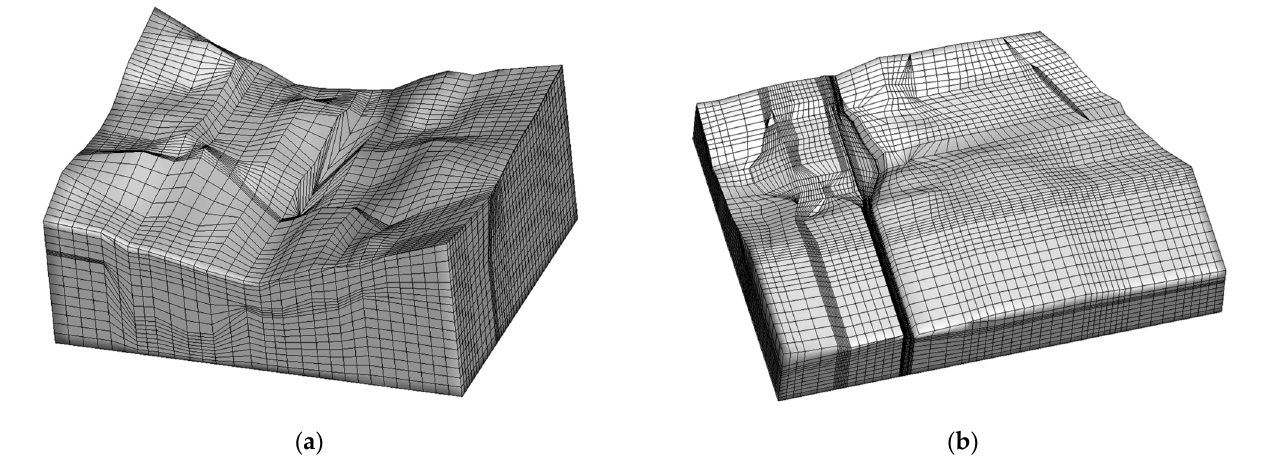
Figure 6. Three-dimensional finite element model of the Hami concrete-face rockfill dam. ( a ) Finite element model of the dam’s natural period. ( b ) Finite element model of the dam’s operation period.